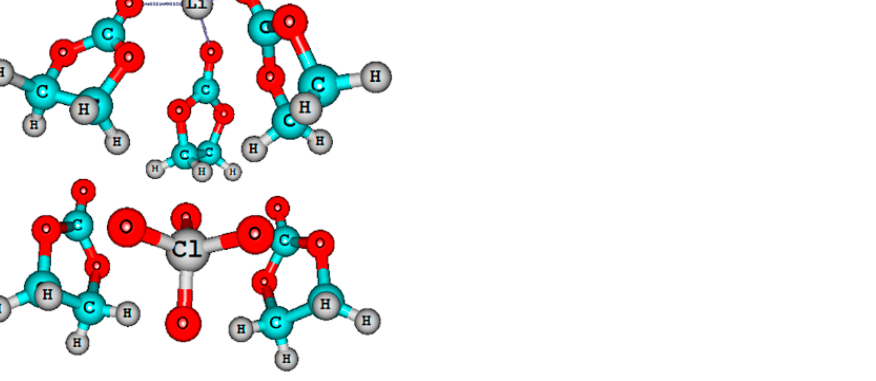
Figure 6. Molecular structures of ionic pair in a 3 molarity LiClO 4 –ethylene carbonate solution [120].